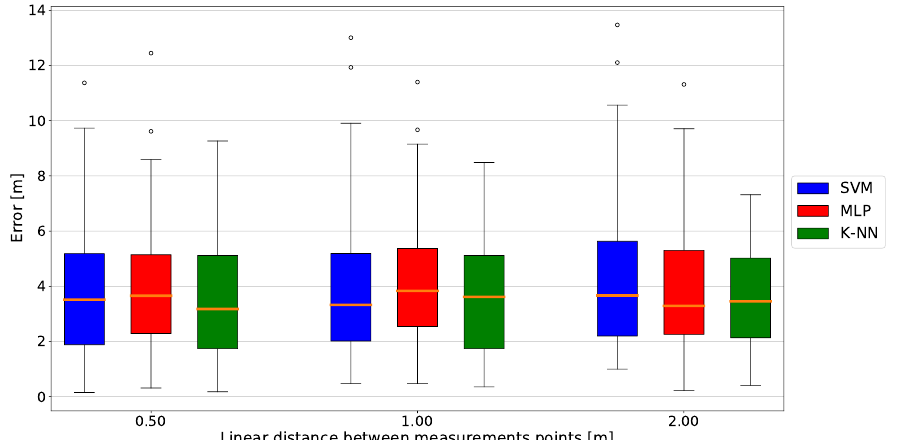
Figure 9. Error box plots for the three fingerprinting algorithms with different fingerprint grid densities in Environment